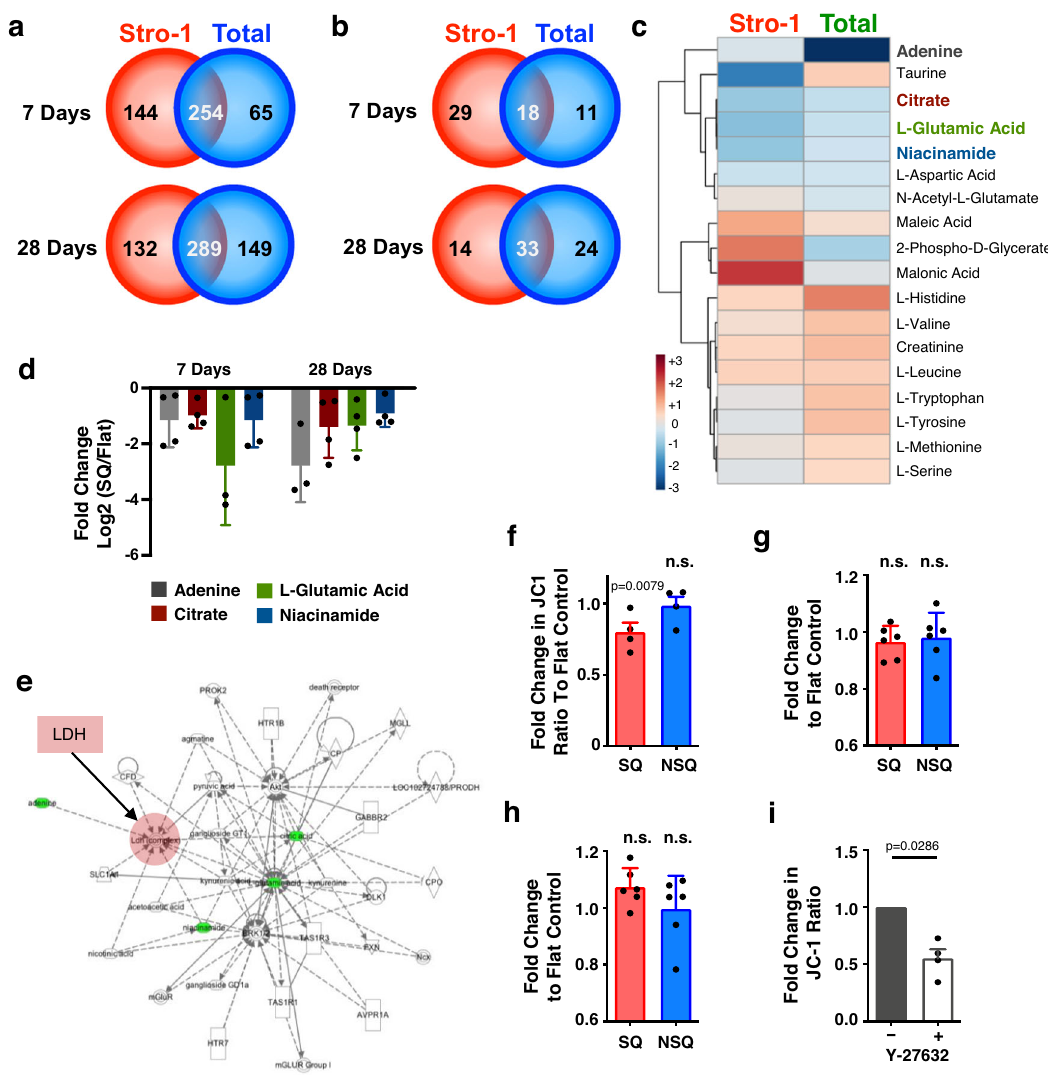
Fig. 2 | Metabolome analysis reveals nanotopography-mediated changes in cellular respiration, independent of mitochondrial dynamics. a Stro-1 + (red) or totalBM(green)MSCswereculturedonSQor fl atsurfacesfor7or28days,andthe number of metabolites speci fi c or common to both cell types were enumerated. Common metabolites with a con fi dence value of 10 were identi fi ed using IDEOM f Changes in mitochondrial activity were measured using JC-1 staining, in MSCs culturedonSQorNSQnanotopographiesrelativeto fl atcontrol.Eachdatapointis